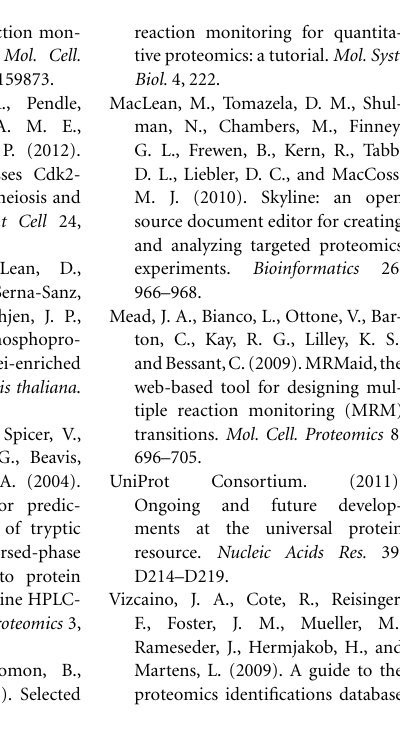
Table S1 | Proteins identified from discovery Orbitrap LC-MS analysis to generate candidate protein list.